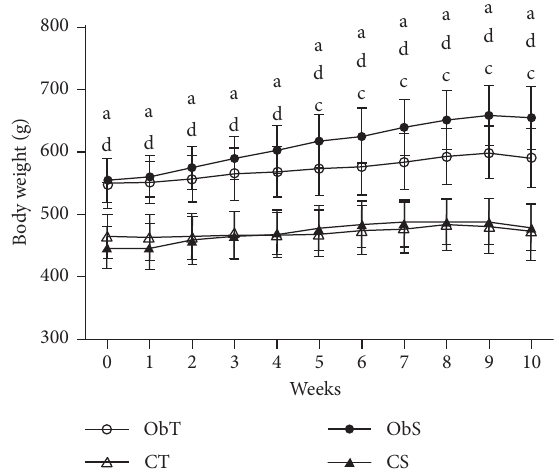
Figure 3: Evaluation of body weight during the training period (10 weeks). Data expressed as mean ± standard